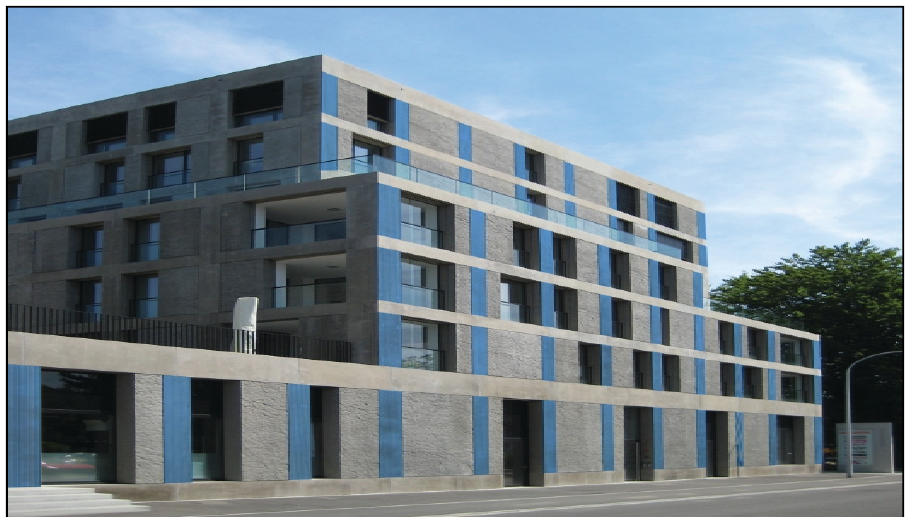
Figure 35. Thin organic solar-cell panels are not restricted to be used in merely glass on building facades but may also be designed to be integrated into cement and metal components.